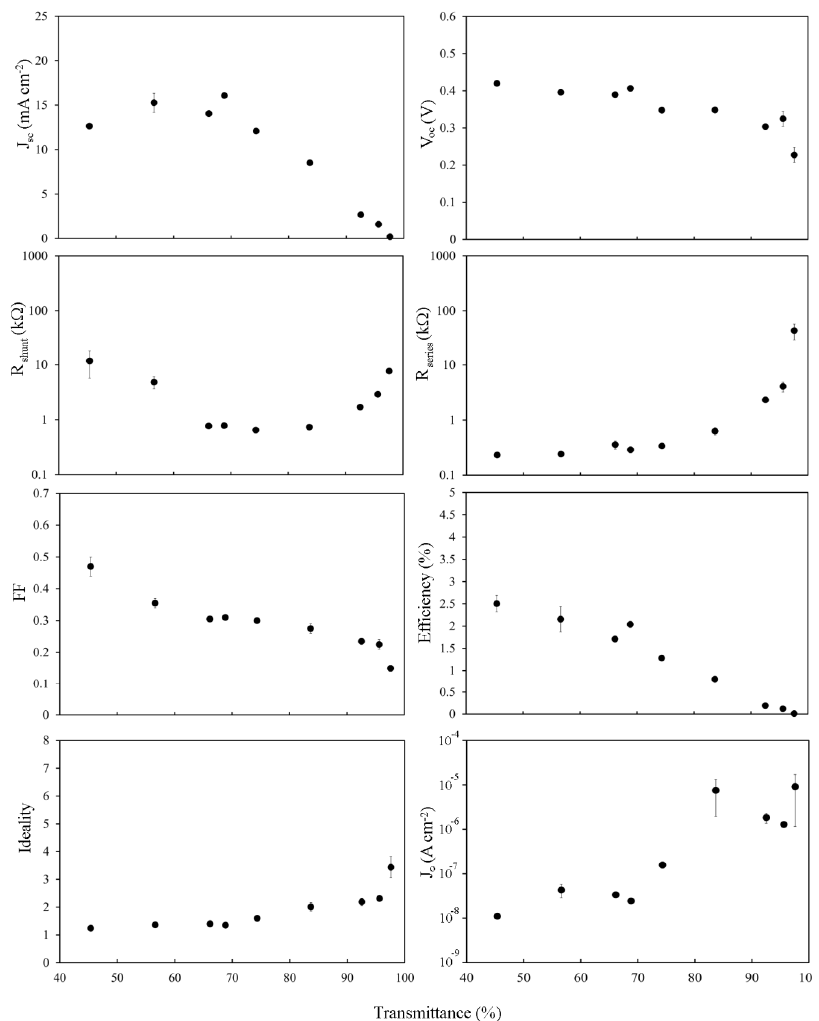
Figure 5. Solar cell parameters extracted from HF treated SWCNT-Si devices with varying SWCNT film thickness, 1 h after